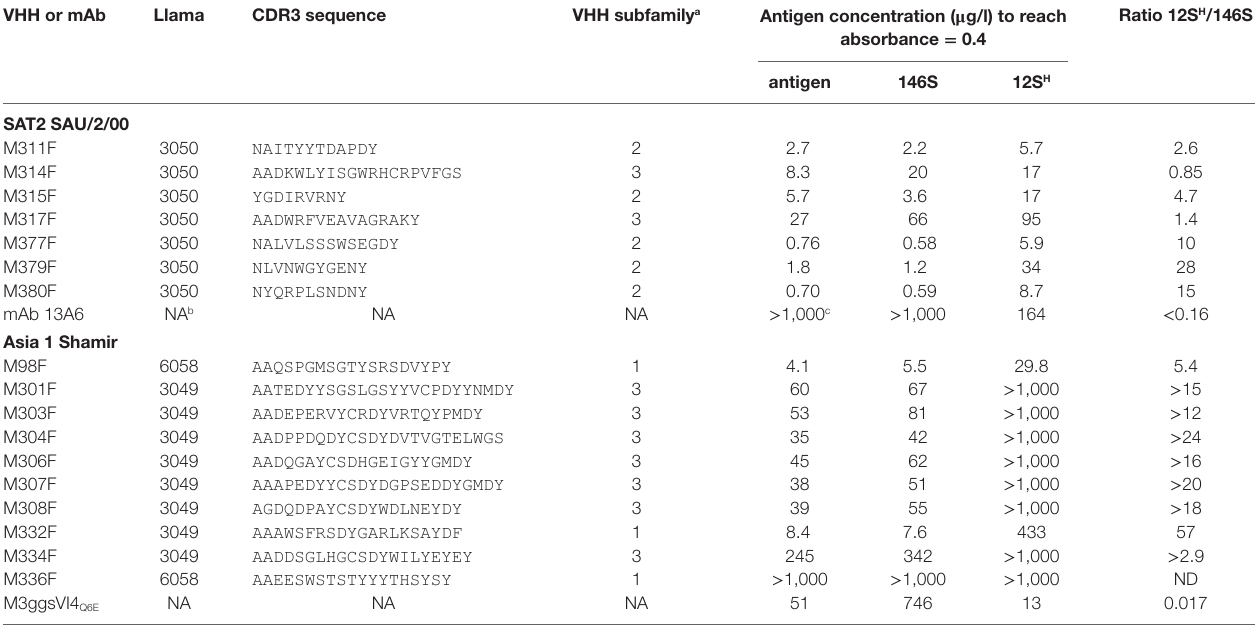
Table 2 | VHH sequence characteristics and specificity of VHHs for 12S and 146S particles in DAS ELISA using the same VHH for coating and as biotinylated VHH. Vhh or mab llama cDr3 sequence Vhh subfamily a antigen concentration ( μ g/l) to reach